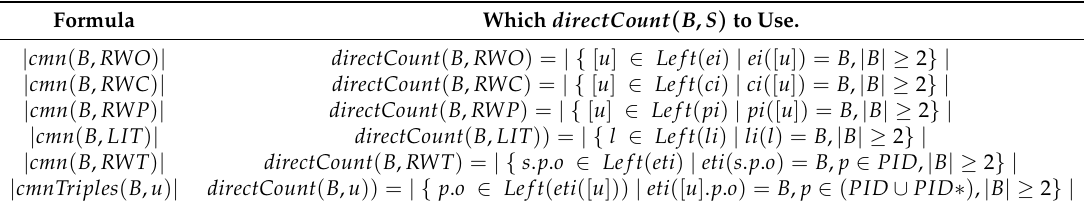
Table 3. DirectCounts of different measurement types.